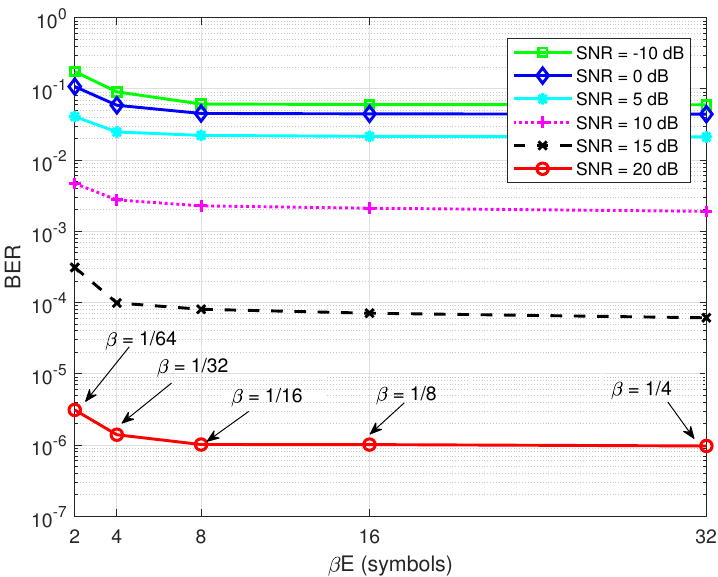
Figure 9. BER versus β E ; R = 1/2, i max = 4, p SI / σ 2 w = 30 dB, and E = 128 symbols.